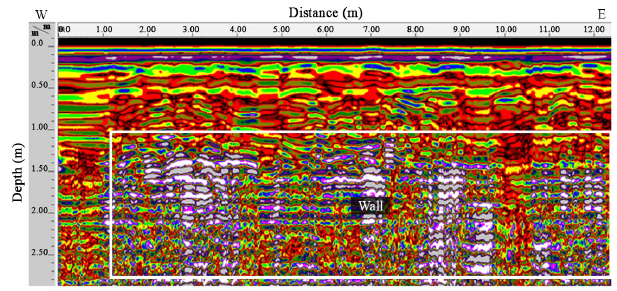
Figure 5. A 900MHz antenna radargram along Profile 9001. The white rectangle along the radargram represents anomaly located be- tween horizontal distance 1 and 3m with approximate depth 0.25m which may correspond to an ancient buried wall. The 4m wide de- pression at end of the profile may be correlated to buried